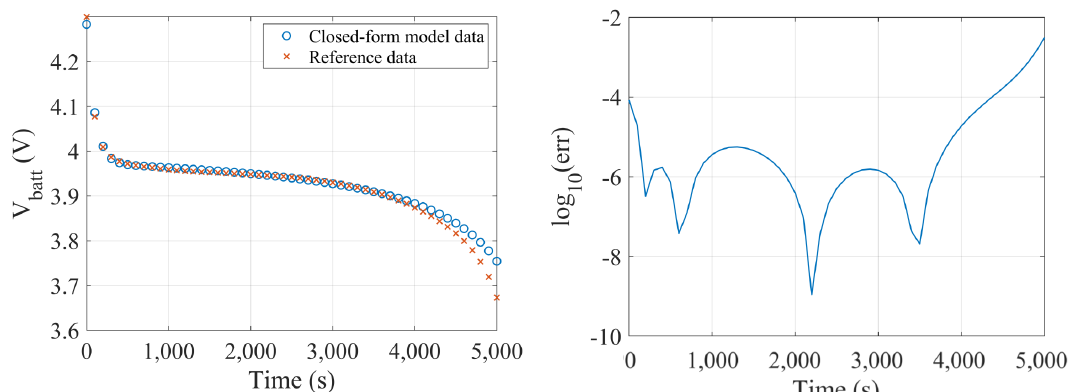
Figure 5. Test for a discharge current of 1.7 A: comparison between the voltage estimated by means of a closed-form parameter-based model and the voltage reference values (on the left ). Absolute error in logarithmic scale between simulated and reference values (on the right ).